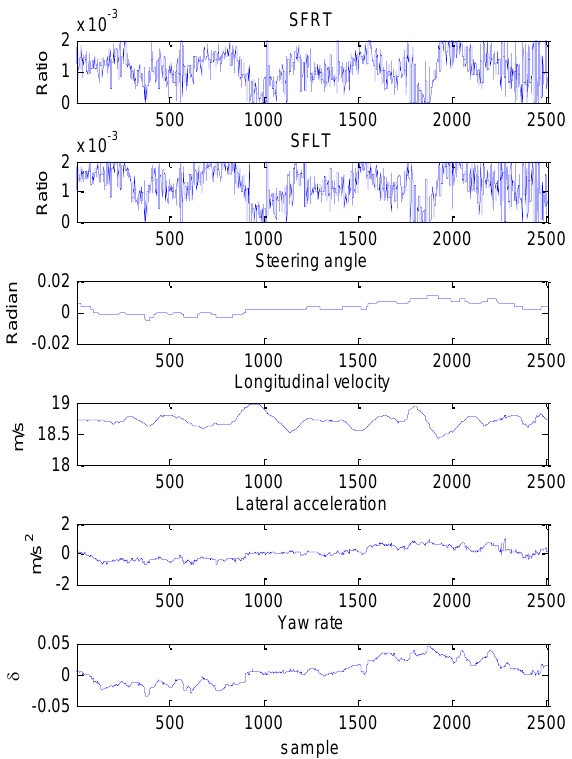
Figure 5. Inputs and outputs for vehicle